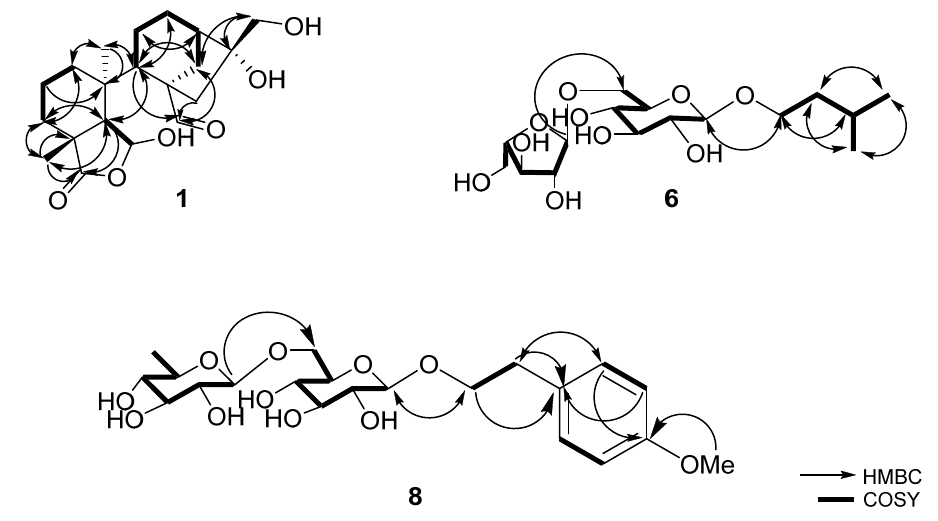
Figure 2. The key HMBC and COSY correlations of compounds 1, 6, and 8.